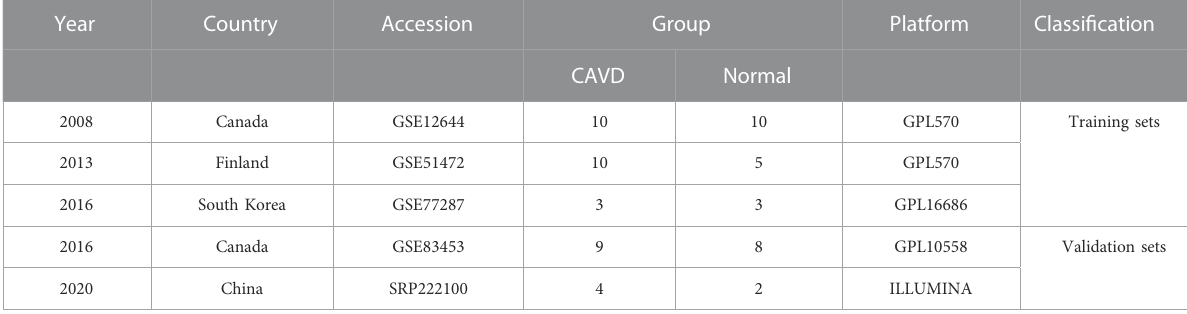
( Figure 3A ) . Results of KEGG pathway analysis revealed